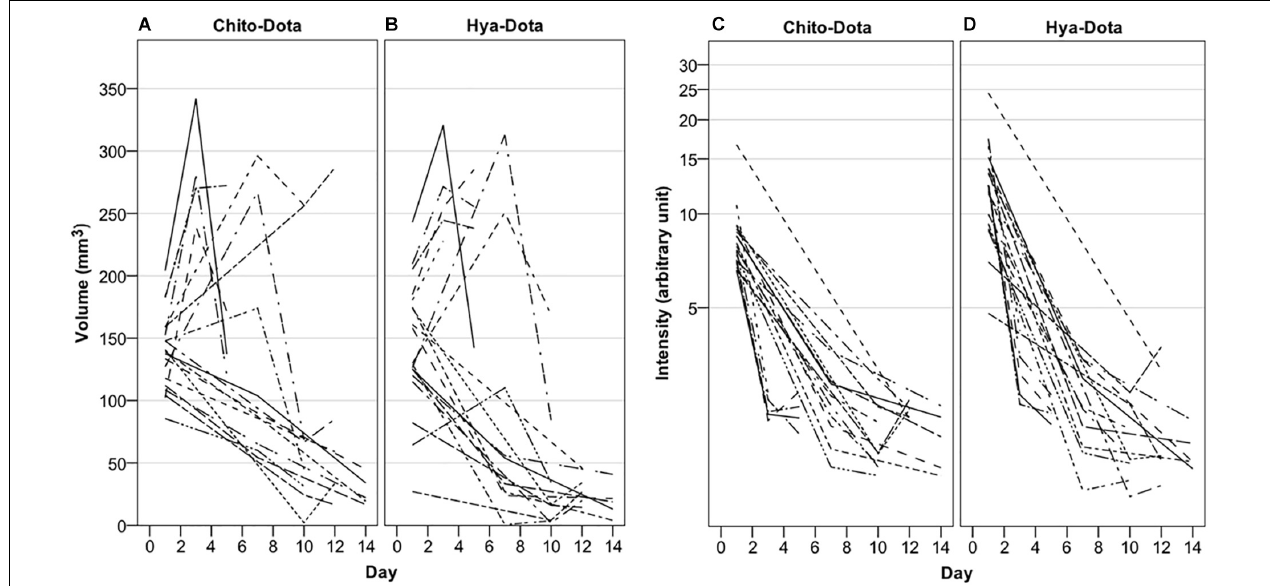
FIGURE 6 | Guinea pigs were subjected to intratympanic IT administration of two different paramagnetic gels, one based on chitosan (Chito-Dota) in one ear and one based on hyaluronan (Hya-Dota) in the contralateral ear. Volume and intensity in the middle ear were explored with magnetic resonance imaging performed on three different occasions in each guinea pig. The volume (A,B) and intensity (C,D) in the middle ear vs. time curves for each guinea pig are shown. n = 19 on day 1, n = 5 on day 3, n = 4 on day 5, n = 9 on day 7, n = 8 on day 10, n = 5 on day 12, and n = 5 on day 14 for both Chito-Dota and